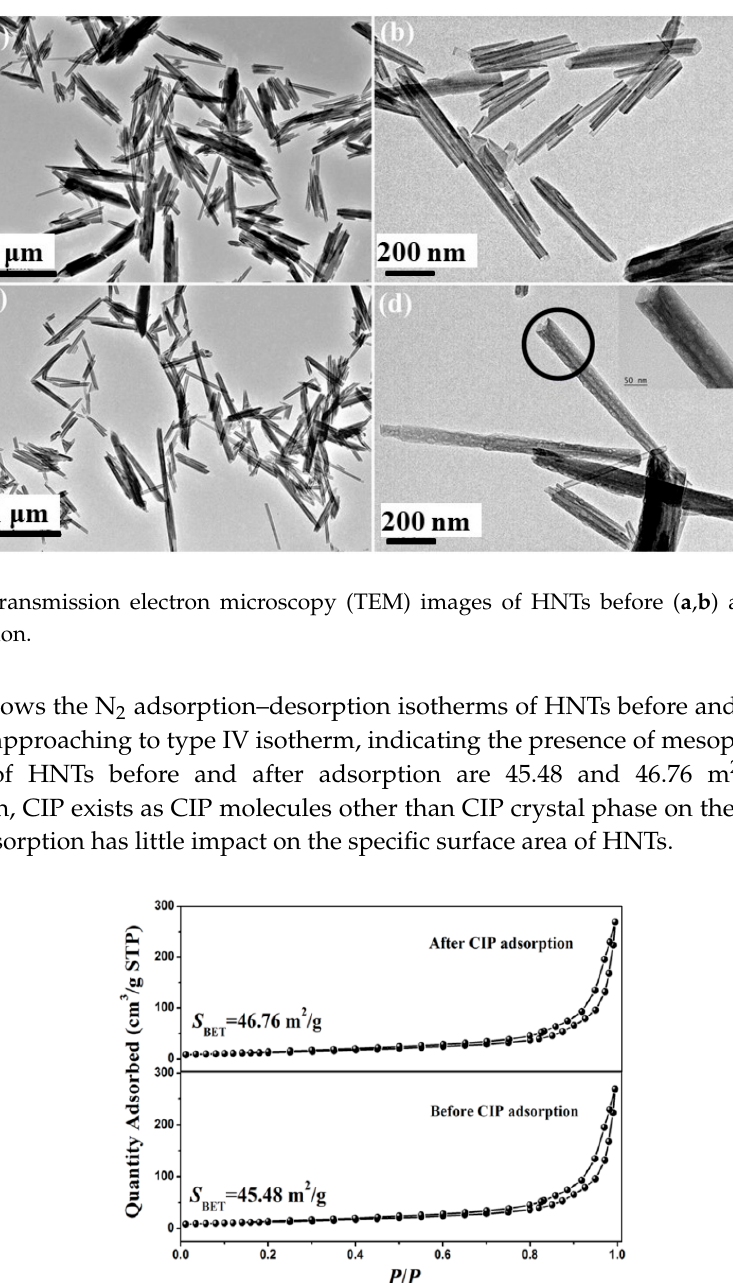
Figure 8. The recycle tests of HNTs as adsorbent for CIP removal. 4. Discussion There are possibly two aspects that contribute to the excellent adsorption efficiency of HNTs: one is the large surface area and the other is the electrostatic attraction between HNTs and CIP molecules. A large surface area could provide lots of readily available adsorption sites for CIP molecules. The sites have a profound effect on the properties and stability of HNTs [50]. Electrostatic attraction could provide a driving force to lead a fast diffusion and rapid equilibrium attainment. Surface charge magnitude is extremely important for an adsorbent, and always should be referred when discussing the adsorption mechanism. Zeta potential measurement is a general method for identifying the surface charge magnitude. Figure 9 shows the zeta potential of HNTs before and after CIP adsorption at various pH values. As indicated in Figure 9, the surface of HNTs